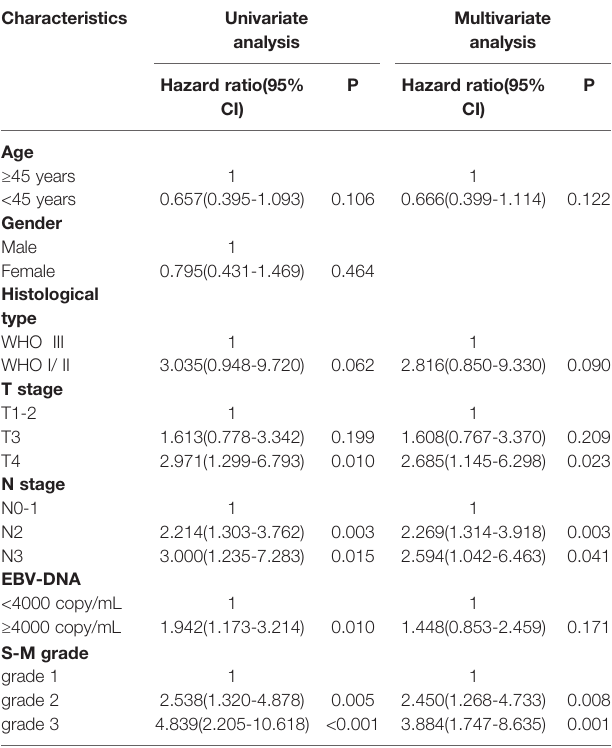
Hazard ratios estimated by Cox proportional hazards regression. All statistical tests were